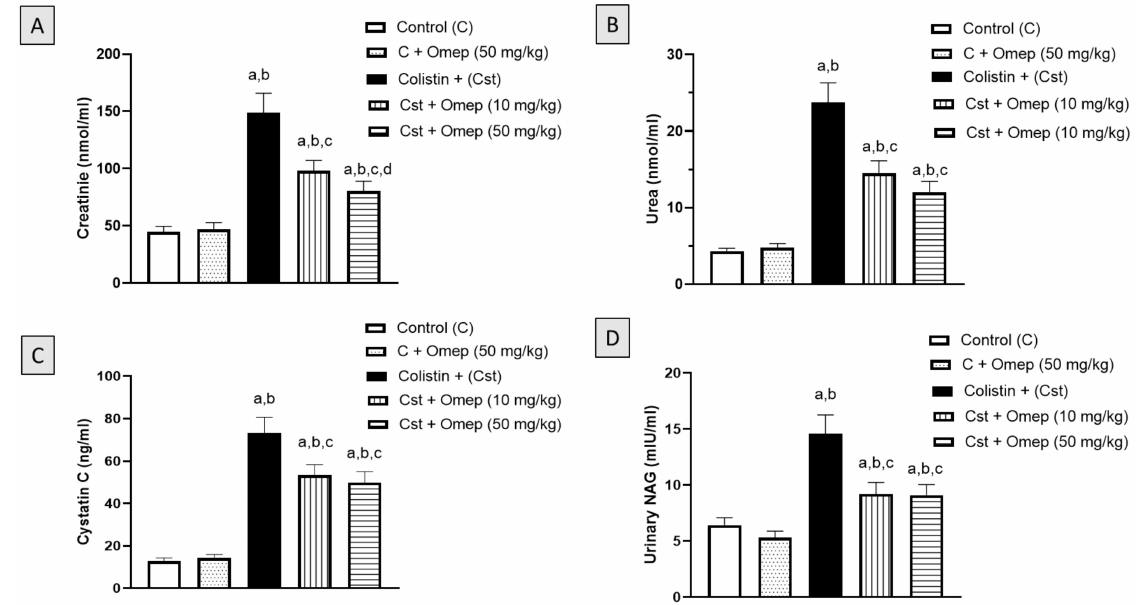
Figure 1. Effect of omeprazole on serum and urinary markers of nephrotoxicity induced by colistin in rats. ( A ): Serum creatinine level, ( B ): Serum urea level, ( C ): Serum cystatin C level, ( D ) Urinary NAG activity. Data are shown as M ± SD ( n = 6). Omeprazole = Omep; Colistin = Cst. a: Significantly different from Control at p < 0.05; b: Significantly different from Omep (50 mg/kg) at p < 0.05; c: Significantly different from Cst at p < 0.05; d: Significantly different from Cst + Omep (10 mg/kg) at p < 0.05.